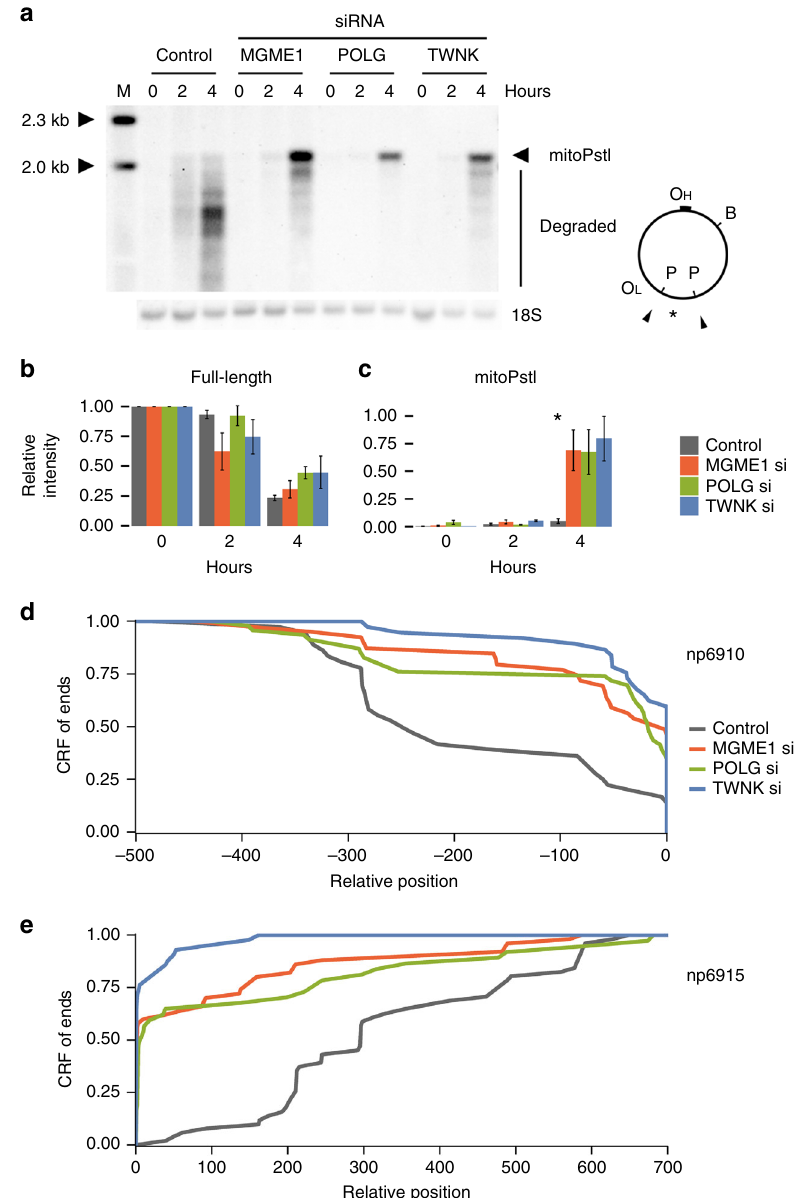
Fig. 2 Degradation of the 2.1-kb mtDNA fragment in control and siRNA-treated mitoPstI-expressing HEK 293 cells. a Southern blot showing the appearance and degradation of the 2.1-kb mtDNA fragment within the fi rst 4 h of induced mitoPstI (P) expression in control cells and in MGME1 , POLG , or TWNK siRNA-treated HEK 293 cells. BamHI endonuclease-linearized DNA (B) was labeled with a mitochondrial probe represented by an asterisk as well as a probe speci fi c for nuclear 18S ribosomal DNA ( ‘ 18S ’ ). b Quanti fi cation of full-length mtDNA con fi rms the ef fi cient cleavage of mtDNA by mitoPstI and c the persistence of the 2.1-kb mtDNA fragment in MGME1 , POLG , and TWNK knockdown cells. Band intensities were fi rst normalized to 18S ribosomal DNA intensities then to intensities of the full-length mtDNA in each cell line at the starting time point and, in panel ( c ), additionally to the highest 2.1-kb fragment value on each blot. Error bars represent standard errors of the mean (SEM) in three independent experiments. Signi fi cance was calculated by applying one-way ANOVA test. * P < 0.05. d , e Cumulative relative frequencies (CRF) of ends around the 6910/6915 cutting site (represented by position 0) 2 h after mitoPstI induction as determined by single-molecule ampli fi cation of linker-ligated free mtDNA ends and subsequent Sanger sequencing. Positions indicated are relative to non-degraded ends at 6910 ( d ) or 6915 ( e ). CRFs were calculated from the following number of detected ends: d control (gray), n = 36; MGME1 siRNA (red), n = 39; POLG siRNA (green), n = 46; TWNK siRNA (blue), n = 37; e control (gray), n = 51; MGME1 siRNA (red), n = 50; POLG siRNA (green), n = 37; TWNK siRNA (blue), n = and partially degraded (Fig. 3d, e) mtDNA ends exists in vivo as (native vs. T4 polymerase treatment ratios of end counts nor- malized to total mitochondrial reads in diverse samples were 1.00 ± 0.13, SEM). If the majority of ends in the sample were not blunt, pre-treatment with T4 polymerase should have increased the number of ligatable ends dramatically. Since this was not the case, we concluded that the majority of non-degraded (Fig. 3b, c)